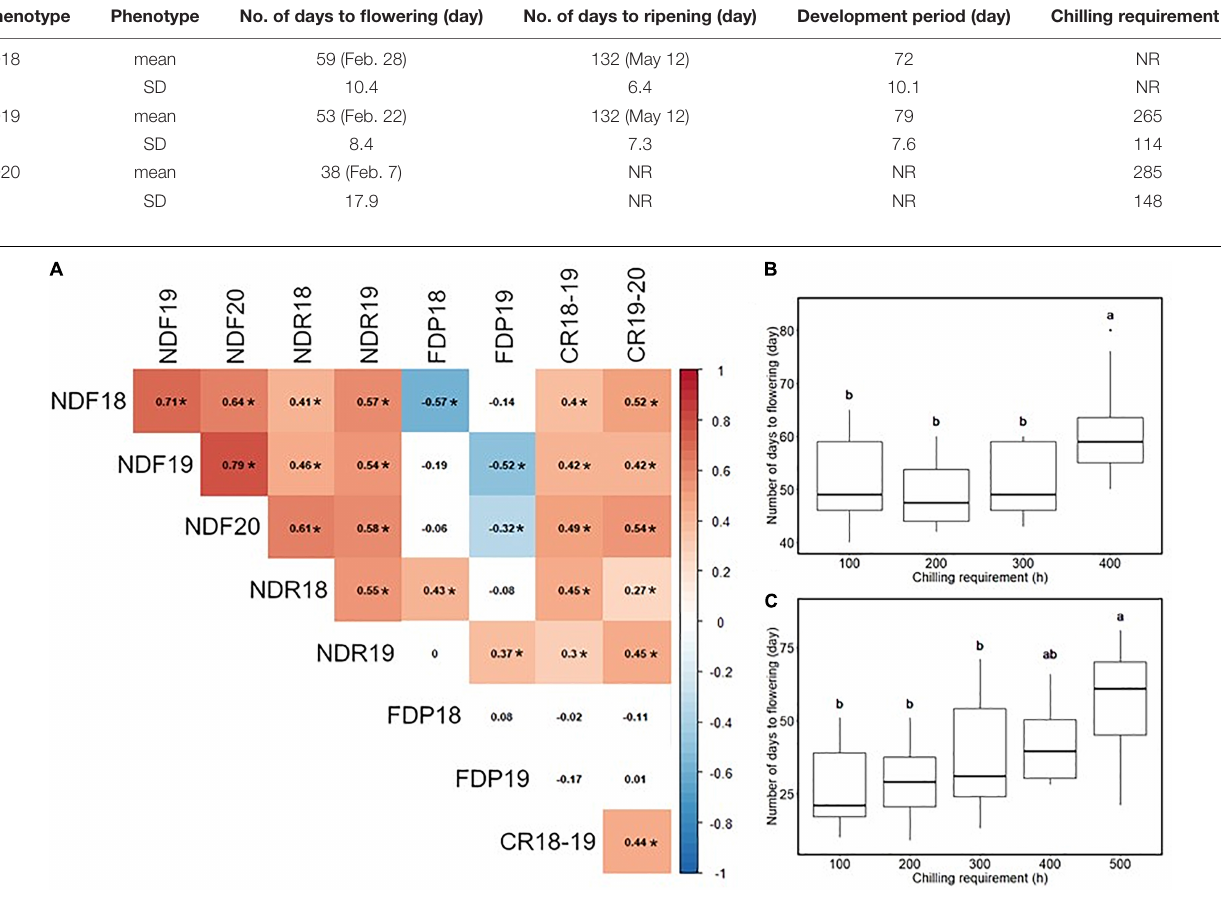
FIGURE 1 | Correlation analysis among the phenology-related traits. (A) The result of Spearman’s rank correlation analysis. Values in cells represent Spearman’s correlation coefficient. The two-digit values at the phenotype ID represent the experimental year. Significant correlations ( p < 0.05) were highlighted by color and indicated by asterisk (*). (B) Relationship between chilling requirement (CR) in 2018–2019 season and the number of days to flowering in 2019. (C) Relationship between CR in 2019–2020 season and the number of days to flowering in 2020. Different letters represent significant differences ( p <